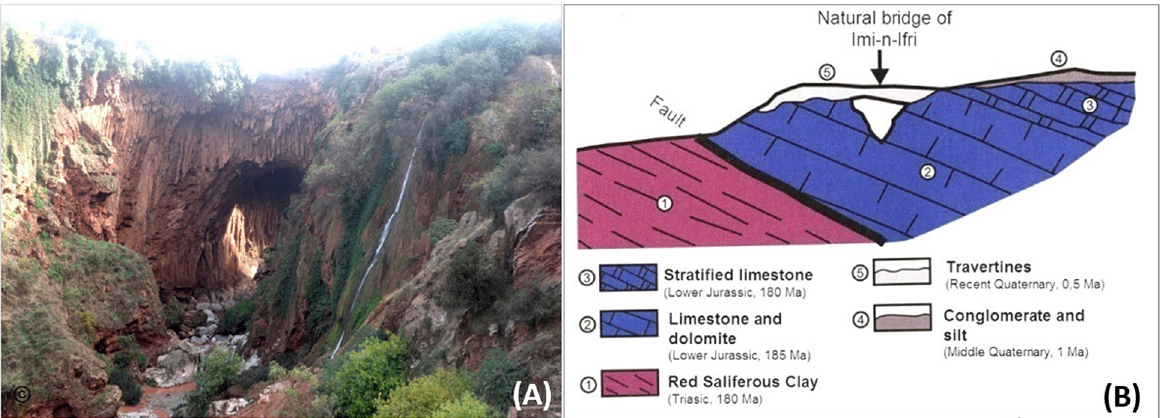
Fig. 5. The geosite of Imi-n-Ifri natural